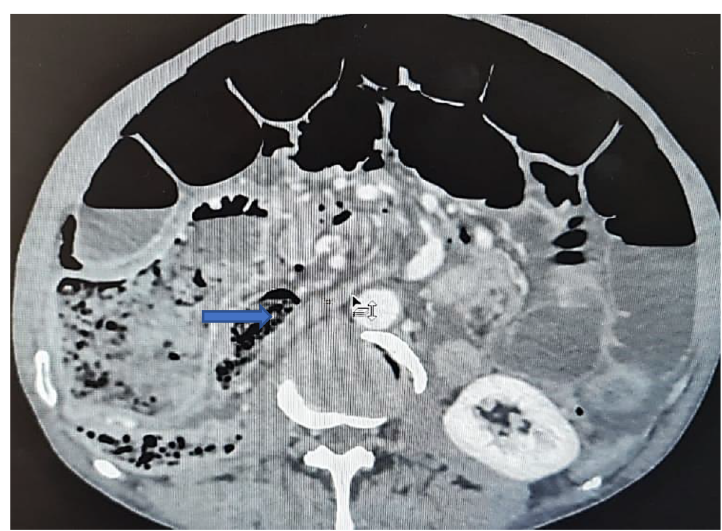
Figure 5. The inflammatory